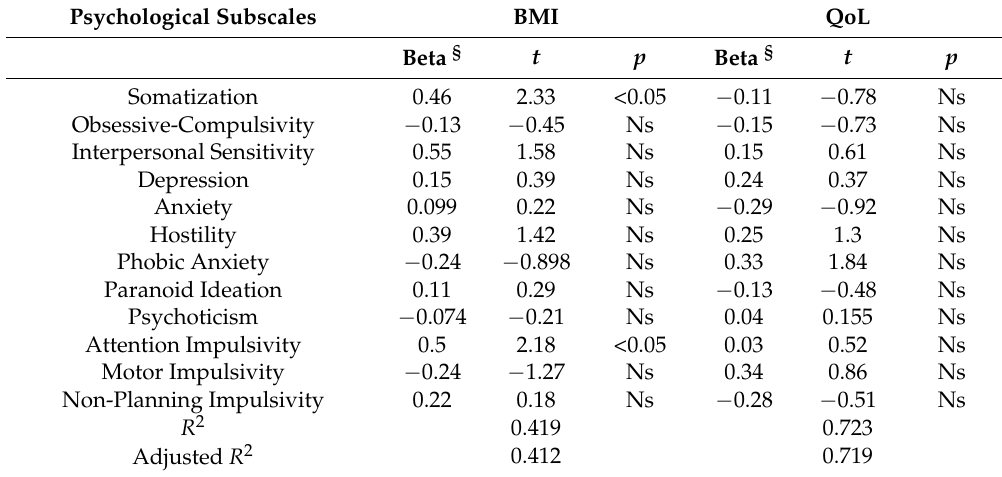
Adjusted R 2 0.412